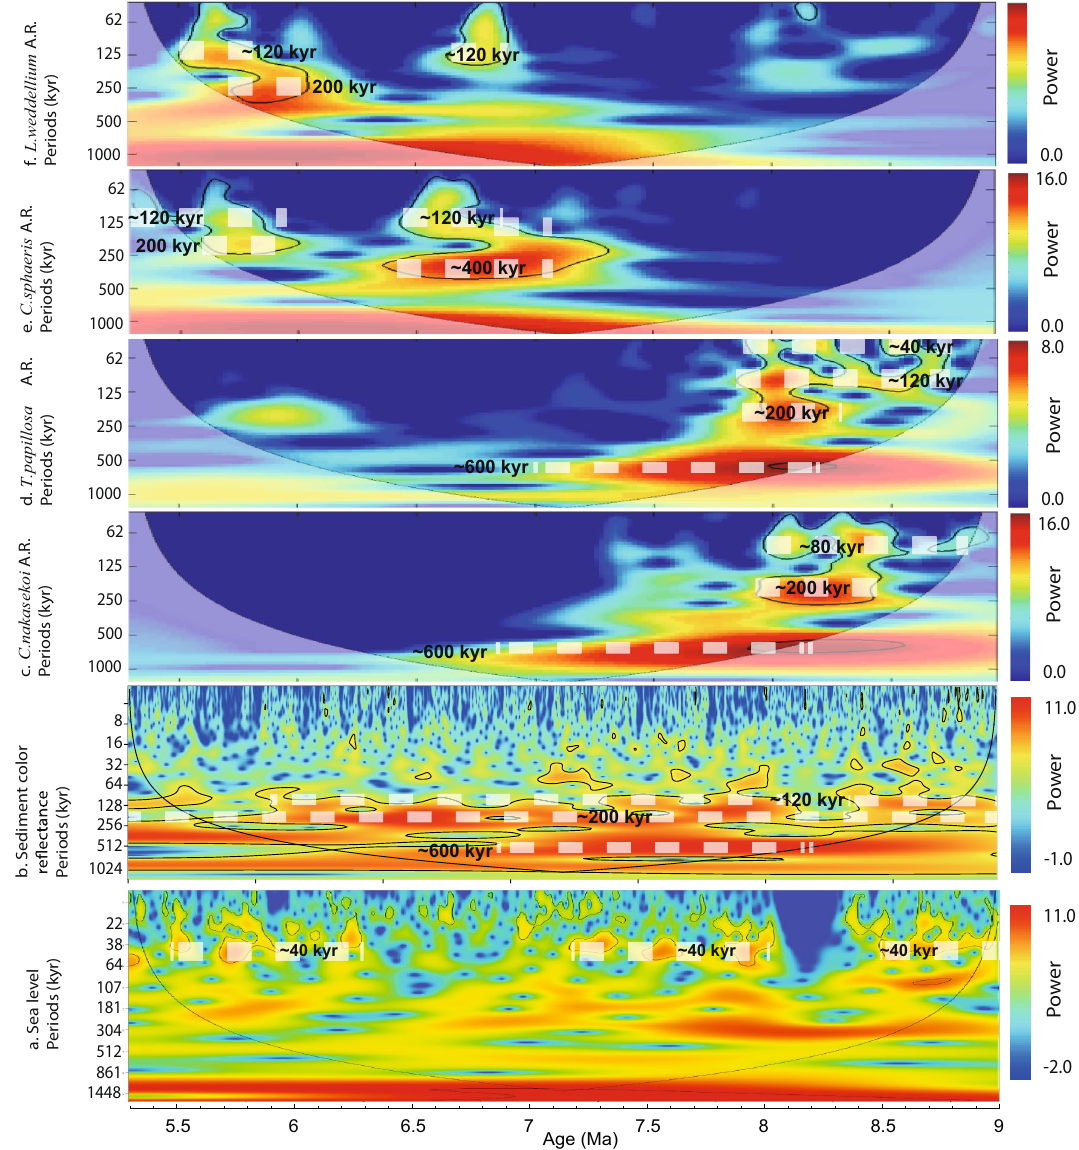
Figure 3. Wavelet spectra of ( a ) global mean sea-level variations 43 and ( b ) IODP site U1425 sediment color reflectance (L*) 33 . Fluxes (accumulation rates in units of skel −1 .cm −2 . ky −1 ) of ( c ) C. nakasekoi , ( d ) T. papillosa , ( e ) C. sphaeris , and ( f ) L. weddellium , all in this study. Area with black outline indicate statistically significant frequencies ( p < 0.05). The wavelet was generated using MATLAB Software version R2022a. (https:// jp. mathw orks. com) and PAST4 Software version 1.0.1 (https:// www. nhm. uio. no/ engli sh/ resea rch/ infra struc ture/